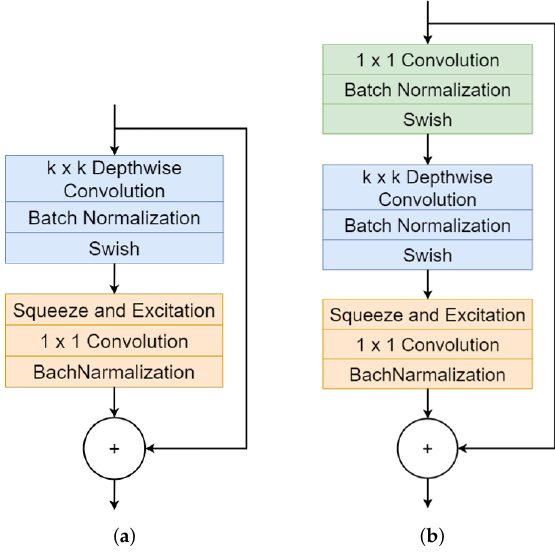
Figure 11. MBConv of EfficientNet [29]. ( a ) MBConv1; ( b ) MBConv6.